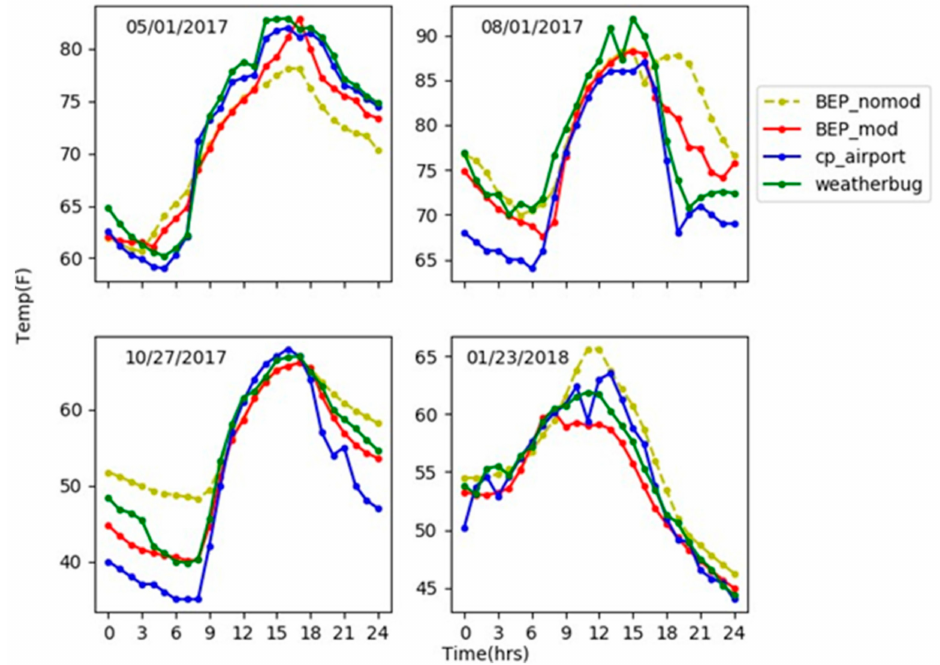
Figure 3. Comparison of two-meter air temperatures simulated by the original BEP (“BEP_nomod”) and improved BEP (“BEP_mod”) for the College Park airport and campus building WeatherBug sites for four di ff erent days in College Park,